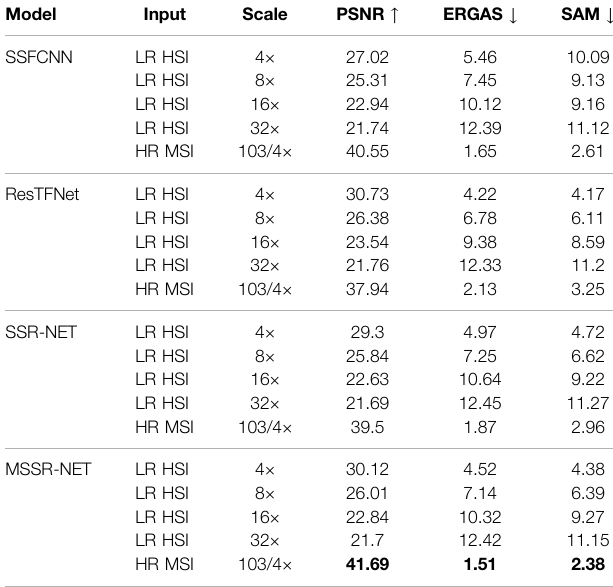
The best scores are written in